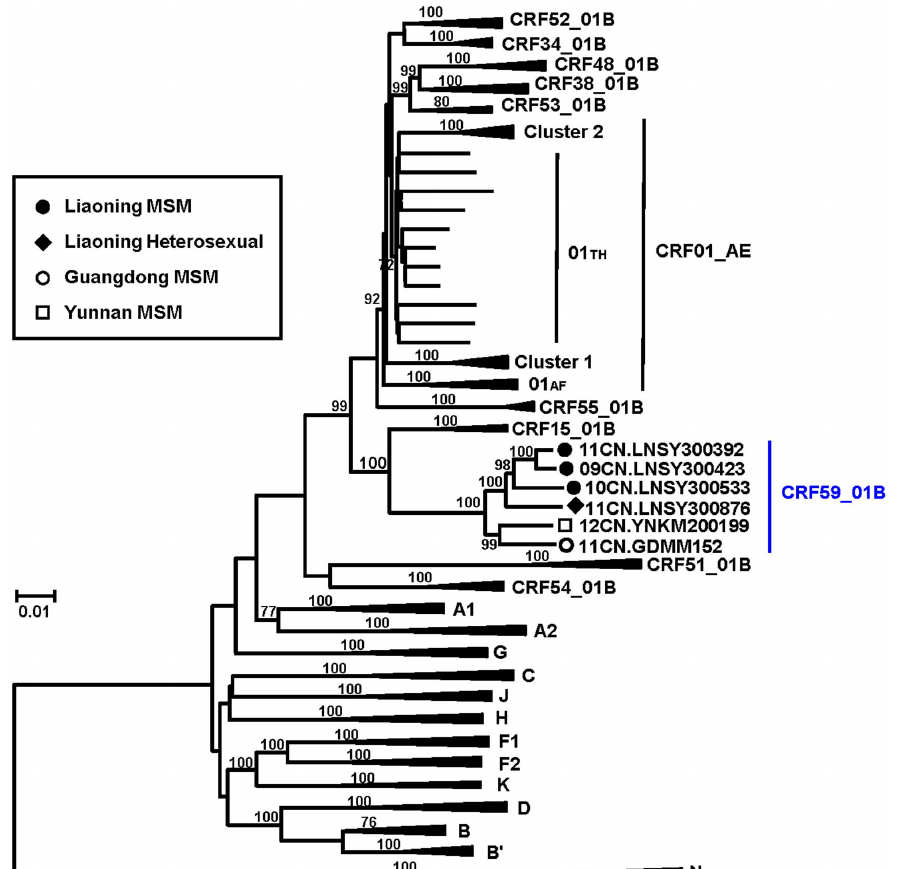
Figure 2. Neighbor-joining tree analysis of the near full-length nucleotide sequences of CRF59_01B. The neighbor-joining tree was constructed using the near full-length nucleotide sequences (8.8 kb) (HXB2: 790–9600 nt) of CRF59_01B strains identified in six epidemiologically- unlinked individuals [five MSM (Bi) and one heterosexual] from China (Table 1). These strains are compared with the reference sequences of all known subtypes/sub-subtypes as well as CRFs relevant to this study, including CRF15_01B, CRF34_01B and CRF52_01B from Thailand; CRF51_01B from Singapore; CRF33_01B, CRF48_01B, CRF53_01B and CRF54_01B from Malaysia; and CRF55_01B from China (http://www.hiv.lanl.gov/content/index). Bootstrap values ( . 70) of the respective nodes are indicated. 01 TH =Thailand CRF01_AE; 01 AF =African CRF01_AE; Chinese MSM clusters 1 and 2=CRF01_AE variants associated with transmission among MSM in China.